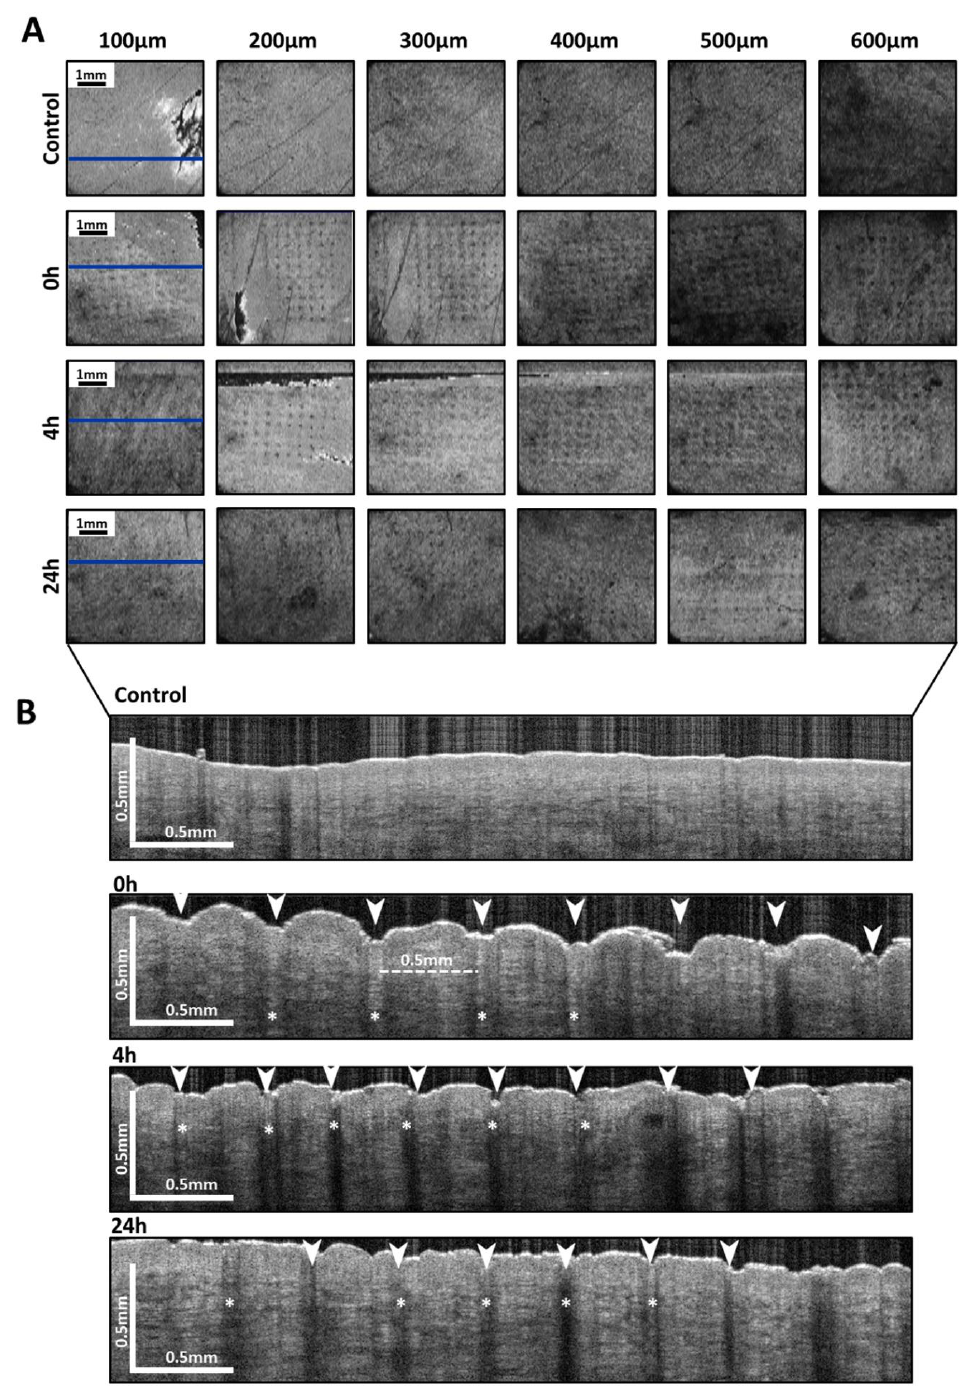
Figure 3. Optical coherence tomography images immediately, 4 h and 24 h after insertion of PRN-loaded MN compared with the untreated skin (control). ( A ) En-face OCT images (XY plane) in projection view of the skin surface obtained from di ff erent depth ranges from 100–600 µ m beneath the skin surface. Scale bar represents 1 mm. The blue line represents one row of the microneedle array, which was subjected to be shown in the cross-sectional view. ( B ) Cross-sectional OCT images (XZ plane) showing the ability of MN to penetrate in ex vivo porcine skin to a depth of approximately 600 µ m, compared with untreated skin (control). Concave indentation of skin surface and disrupted stratum corneum ( arrowhead ). Tips of MN occupied in microchannels, which were dissolved over time ( asterisk; * ). Scale bars represent 0.5 mm.